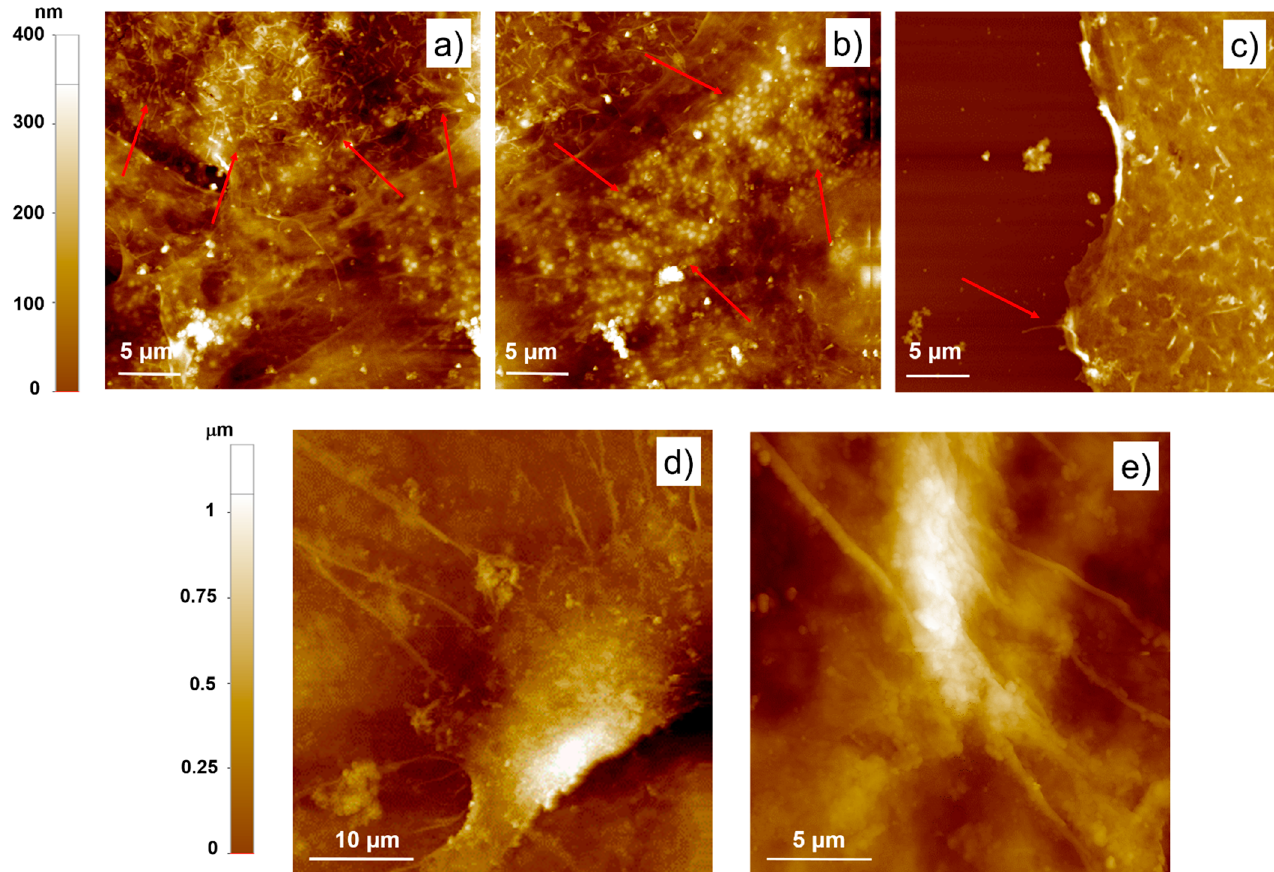
Figure 3. AFM characterization of fibroblasts adhered to glass substrate and PEDOT:Nafion. AFM topography images of primary rat fibroblasts after 12 h from seeding on control glass ( a – c ) and PEDOT:Nafion ( d , e ) substrates. In ( a , b ), the actin filaments of the cell cortex and the round membranous vesicles (indicated by red arrows) are shown, respectively. In ( c ), a detail of a typical cell lamellipodium characterized only by small and rare filopodia (marked by the arrow) is shown. In ( d , e ), two different well-adhered fibroblasts on PEDOT:Nafion coating and showing well-developed filopodia are shown.